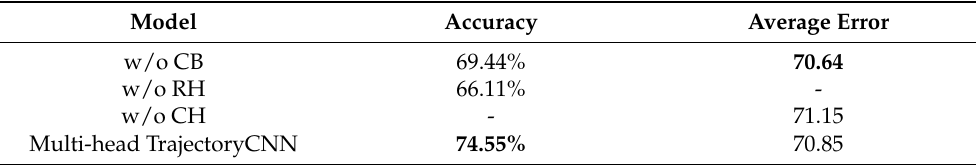
Table 2. Ablative results, where the bold denotes the best